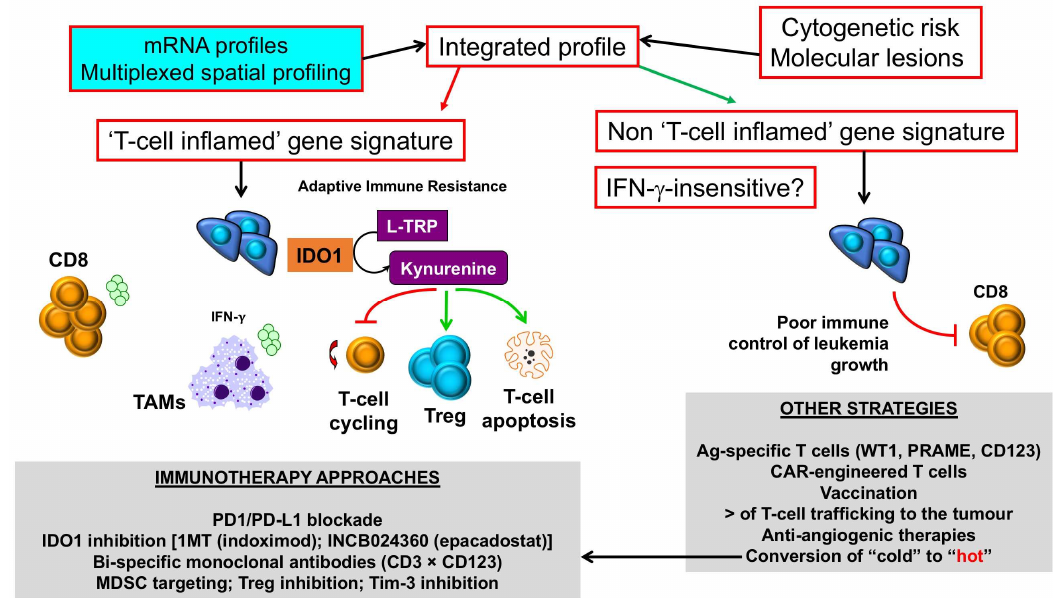
Figure 3. Selection of immunotherapy approaches in AML with inflamed versus non-inflamed TMEs. Messenger RNA (mRNA) profiles and spatially-resolved expression of immune checkpoints could be integrated with conventional AML prognosticators, such as patient age, presenting white blood cell count and ELN cytogenetic risk, to stratify patients into categories with different survival probabilities. Patients with T-cell inflamed profiles, indicative of adaptive resistance-driven immune dysfunction, could be considered for immunotherapy approaches that incorporate IDO1 inhibitors [86], either as monotherapy or in combination with PD-1/PD-L1 ICB [87], or other immunotherapy agents that deliver an activation signal to T cells, including CD3 × CD123 DART proteins [9], and/or revert MDSC- and Treg-mediated immune dysfunction in the TME. In contrast, AML cases with a non-T-cell inflamed TME, and/or blast cells lacking IFN-γ responsiveness as a result of abnormalities in intracellular signaling pathways, could be candidates for therapeutic strategies that enhance T-cell trafficking into the BM (STING agonists, β-catenin inhibitors [31]) and/or passive immunotherapy approaches such as the infusion of leukemia antigen-specific T cells or CD123-CAR T cells [115]. Pharmacological approaches, including the use of hypomethylating agents, could enhance T-cell infiltration to the BM, thus converting a “cold” TME into a “hot” TME [110]. IDO1 = Indoleamine 2,3-dioxygenase-1; L-TRP = L -tryptophan; 1MT = 1-methyl-tryptophan; CAR = chimeric antigen receptor; TAM = tumor-associated macrophage; Treg = regulatory T cell; MDSC = myeloid-derived suppressor cell; WT1 = Wilms’ tumor 1; PRAME = preferentially expressed antigen in melanoma. Green arrows denote stimulation; red arrows denote inhibition.